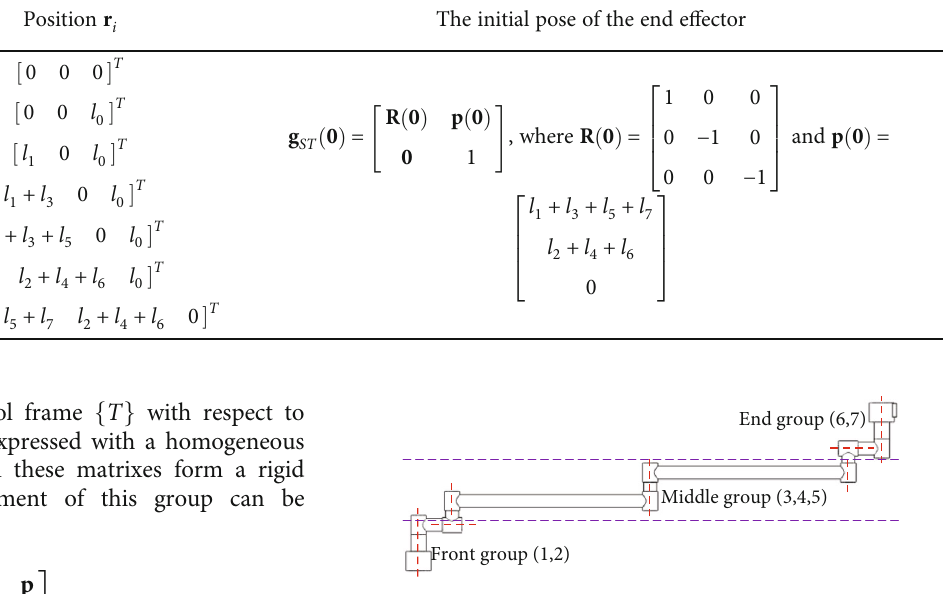
Figure 4: Classi fi cation of the